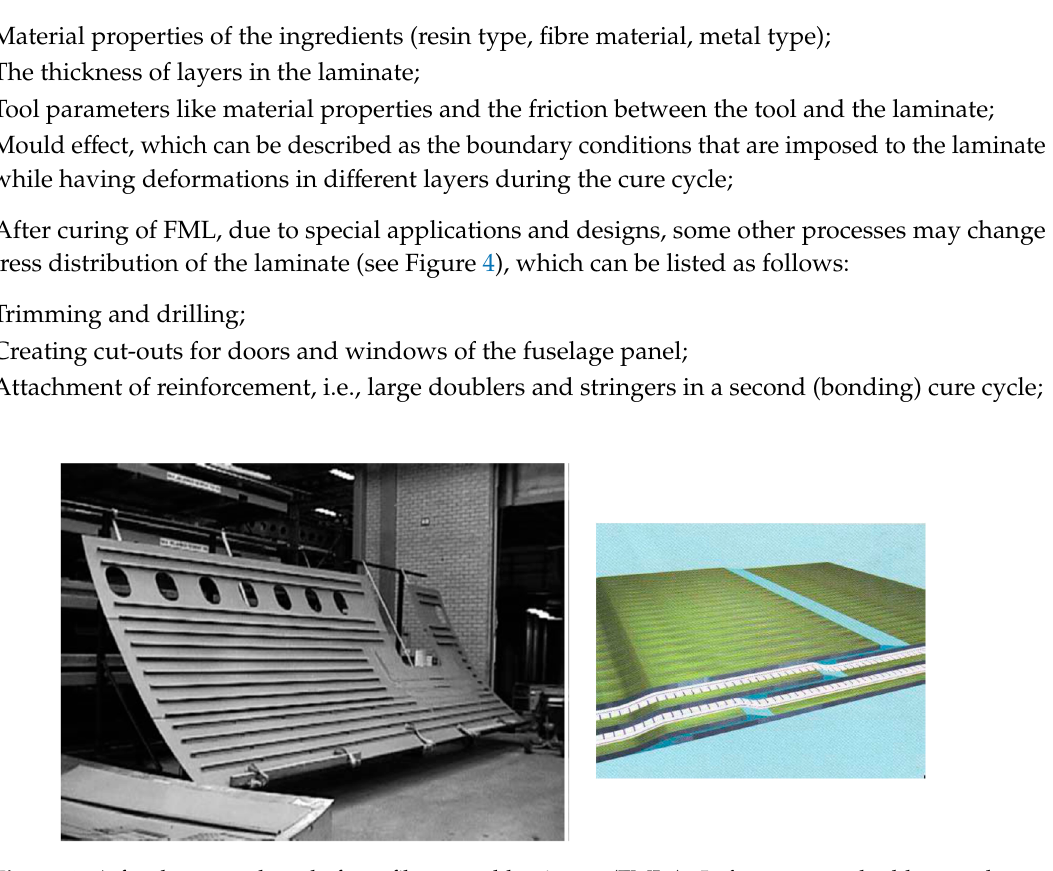
Figure 4. A fuselage panel made from fibre metal laminates (FMLs). Left : cut-outs, doublers, and stringers; right : overlap splice between adjacent panels.